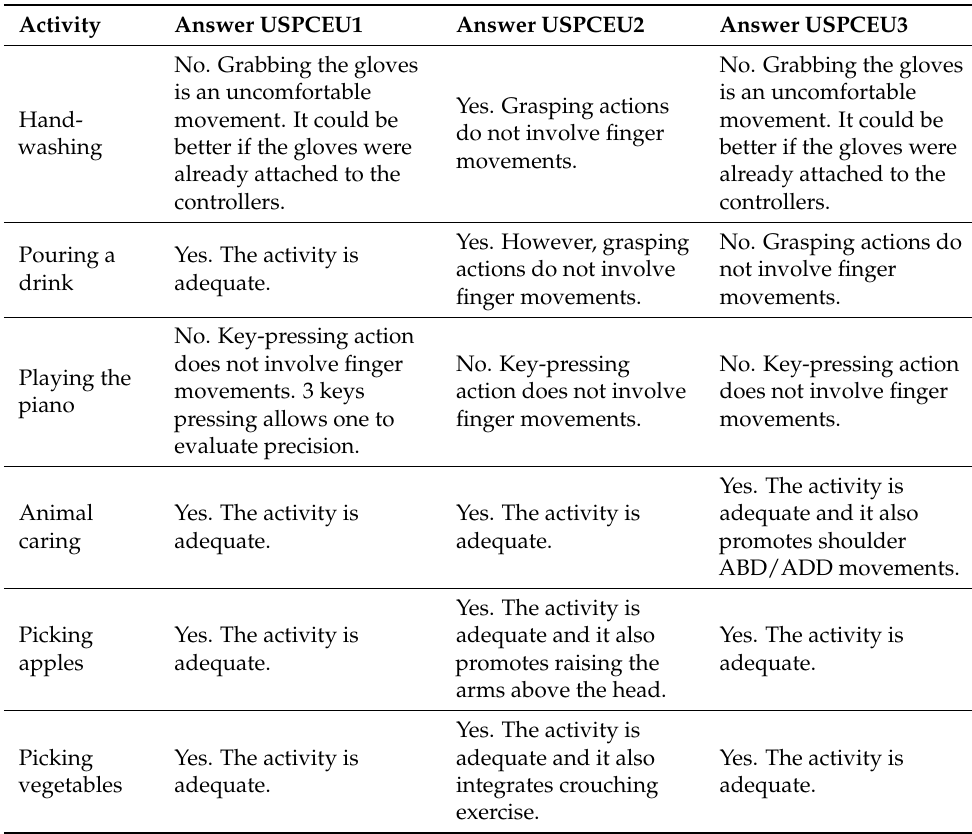
Table 8. Results of activities’ evaluation by USPCEU